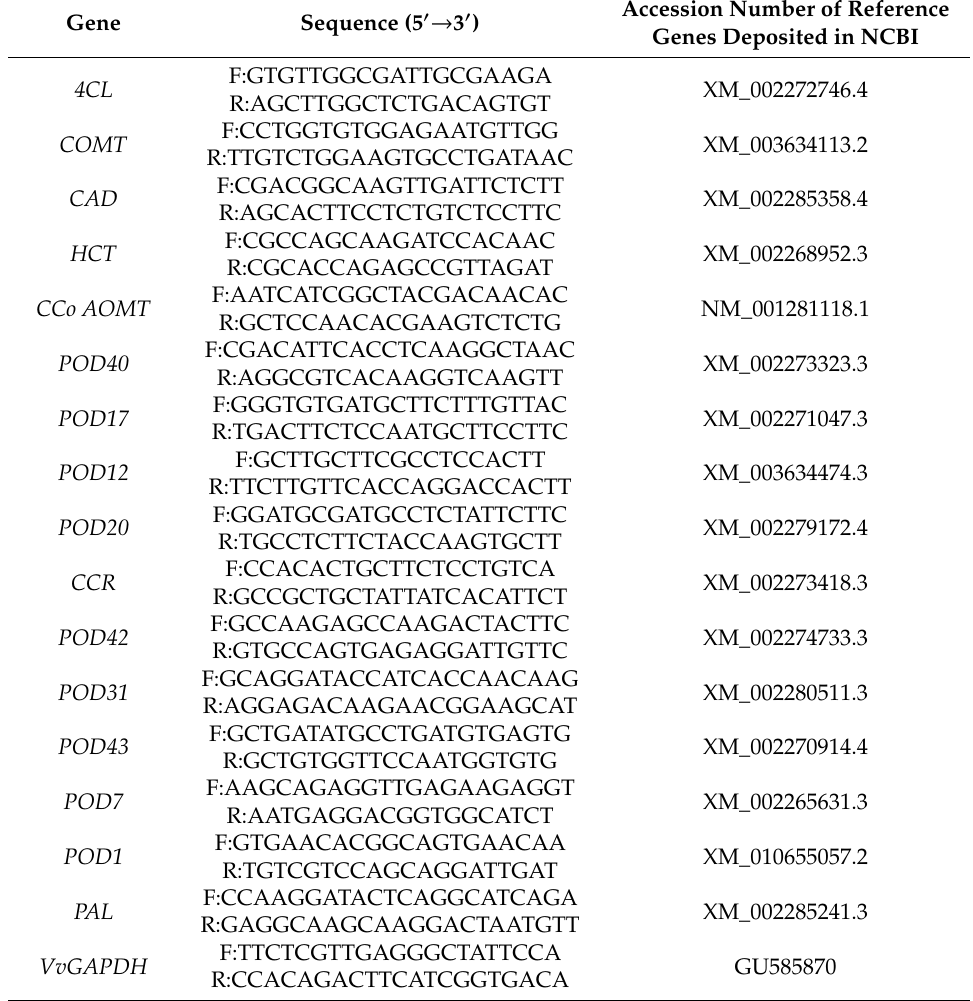
Table 1. Gene primers for